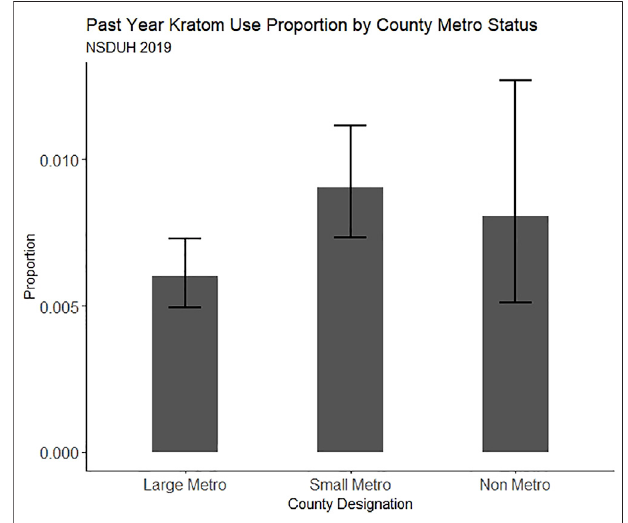
FIGURE3| ProportionofpeoplereportinglifetimekratomuseinNSDUH 2019, split by county metro status. Error bars represent the estimate 95% con fi dence